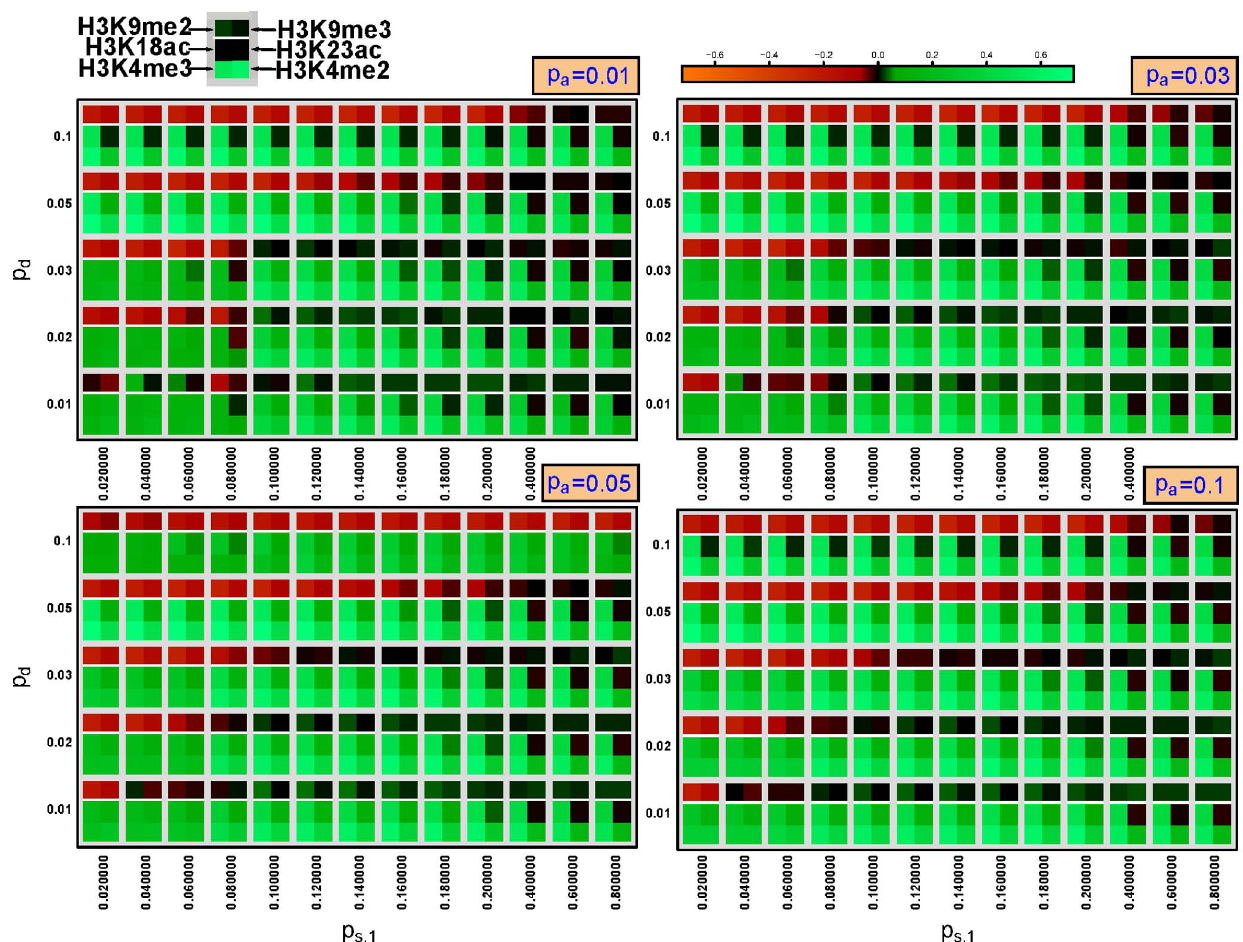
Figure 4. Pearson’s correlation between simulations and experiments on chromosome 1 of CD4 + cells for different values of the parameters p s ,1 , p d and p a . A higher value corresponds to a higher correlation between the simulated chromatin distribution averaged over the last 100,000 time steps and the scores for the histone marks from the ChIP-seq analysis. The heterochromatin marks H3K9me2 and H3K9me3 were compared to the simulated heterochromatin distribution and the marks H3K4me2, H3K4me3, H3K18ac and H3K23ac to the simulated euchromatin distribution. Hence, a good match between simulations and experiment is obtained for all 6 fields being green. The heterochromatin marks are rather sparsely distributed and therefore only low correlation values could be reached, especially for the H3K9me3 mark.